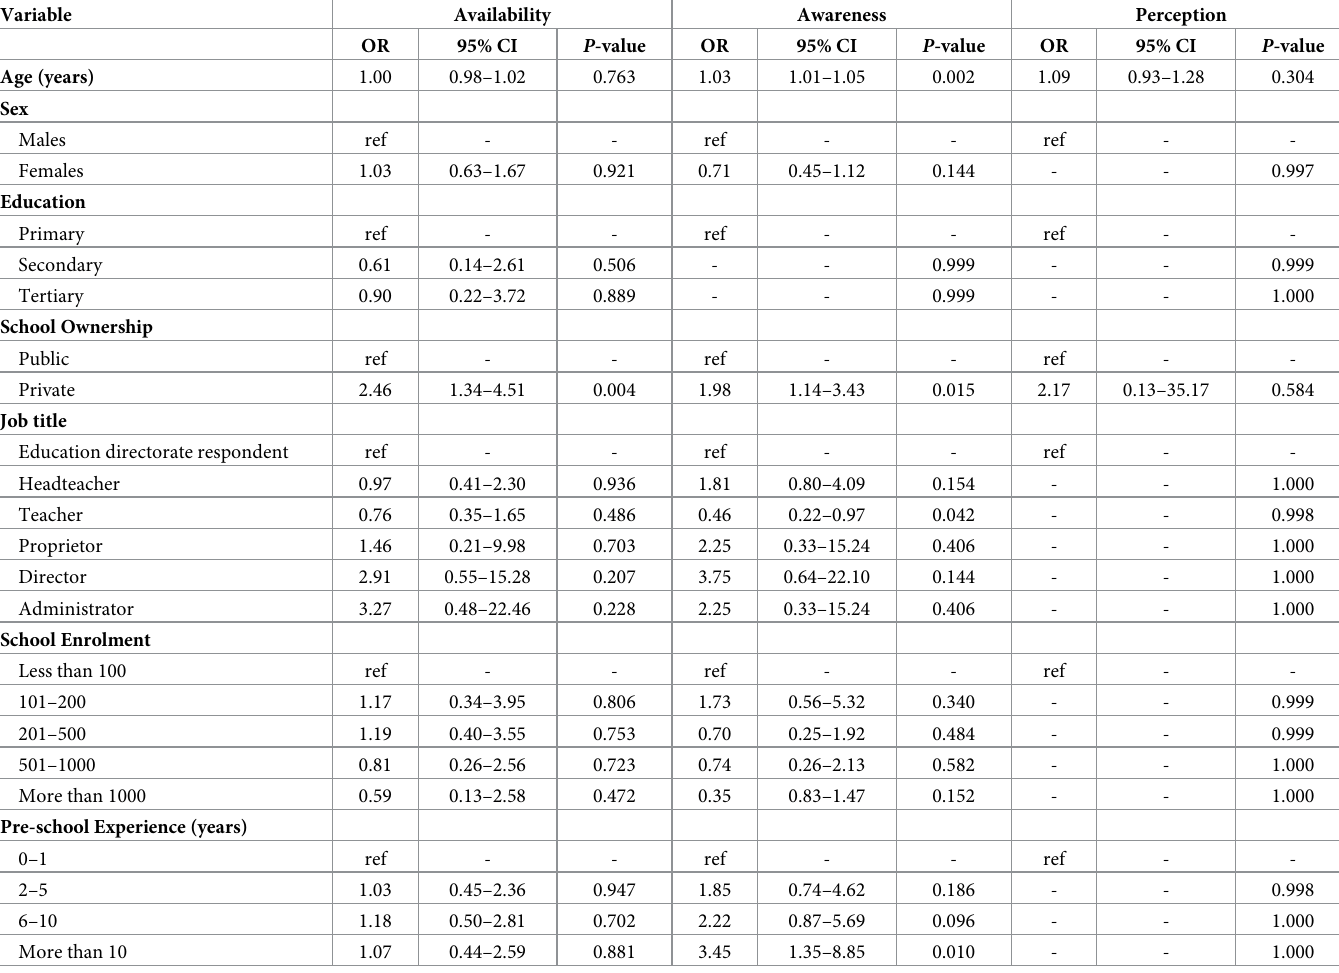
Table 2. Association between sociodemographic factors and availability/awareness/perception of preschool vision